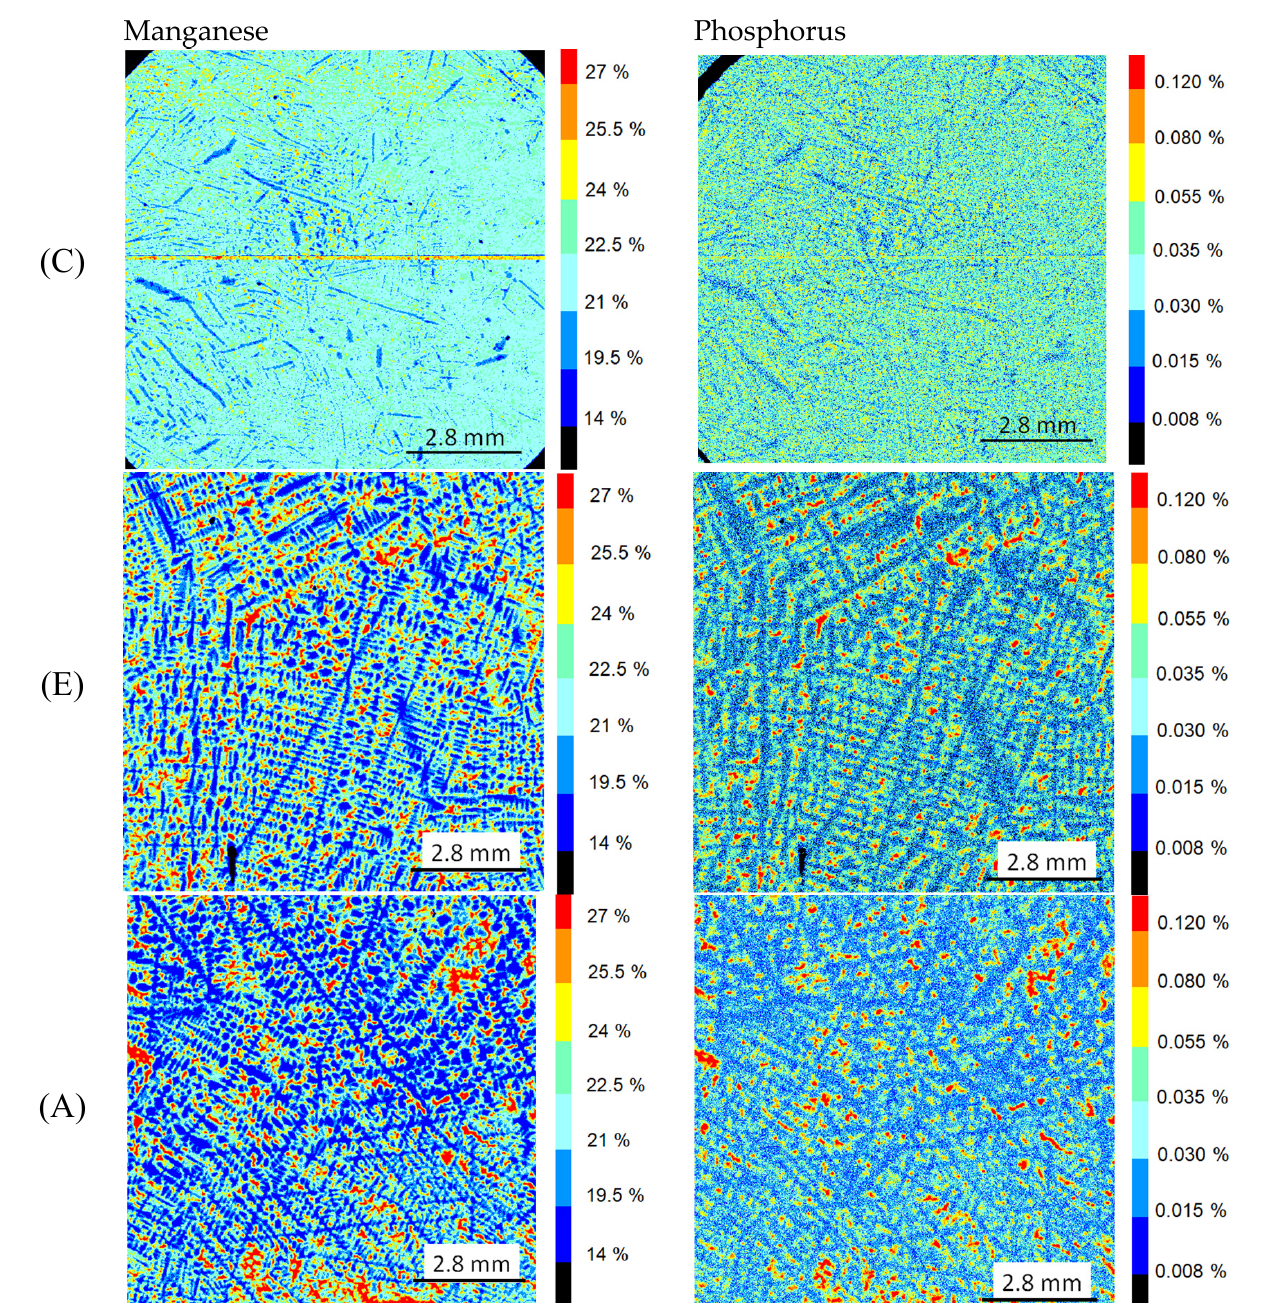
Figure 4. EPMA maps showing the distribution of Mn ( left ) and P ( right ) in the columnar grain ( top row ) equiaxed grain ( middle row ) and axial ( bottom row ) regions. The colour bars are %. wt. Table 2. Average and peak macro-segregation ratios in regions E (equiaxed) and A (axial). Most notably, the peak segregated P content attains values of 0.13 wt.%, i.e., more than four times the nominal in these regions. No maps of C or V distributions in as-cast slabs were made. However, EPMA maps from other studies have shown that V also segregates to interdendritic regions [27]. C segregation is also significant. This element co-segregates strongly with Mn as illustrated by the transmission electron microscopy (TEM) electron energy loss spectroscopy (EELS) data [28] from a cold-rolled and annealed strip of Fe-0.7C-22Mn alloy (Figure